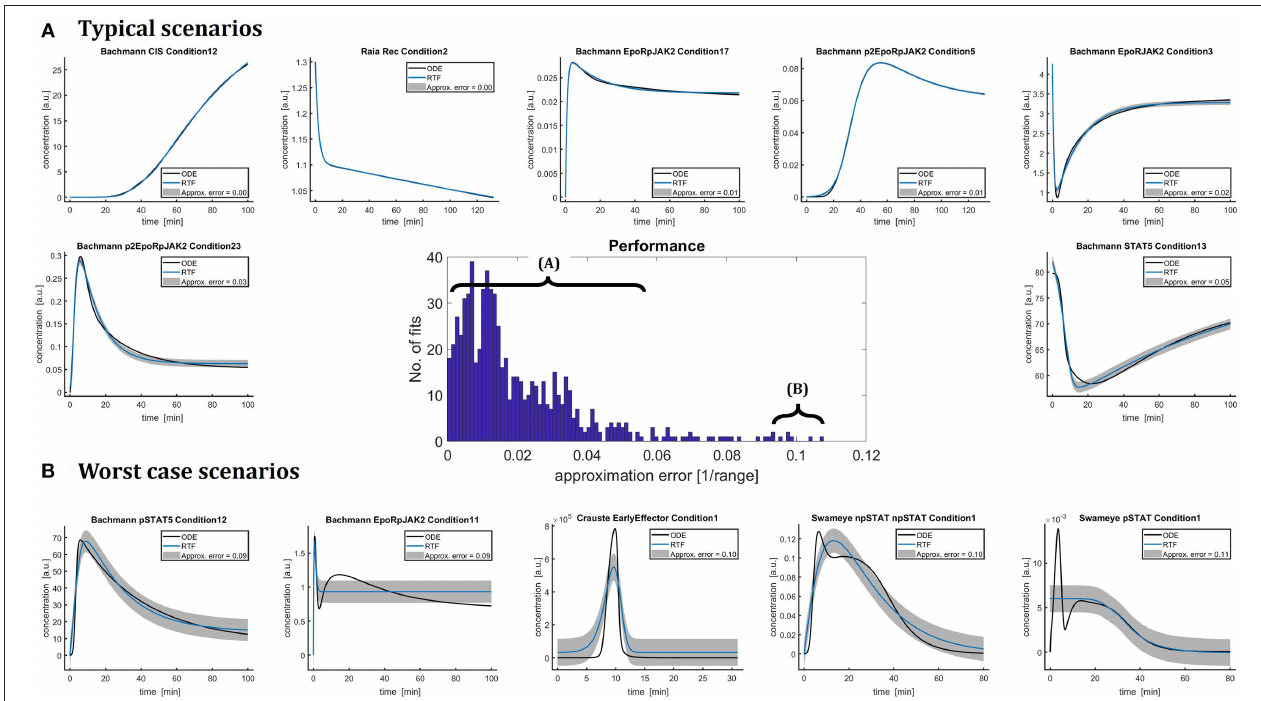
FIGURE 2 | The dynamics of 797 numerical ODE solutions x ( t ) from the nine different benchmark models were fitted by the RTF in order to assess and illustrate the capacity of the RTF (11), (12) for approximating ODE solutions (black lines). The underlying equations of the ODE models originate from the original publications and were taken from the benchmark collection [ 2]. The fitting has been performed based on (13), (18)–(21). The histogram in the center shows the distribution of the resulting approximation errors (15). These errors are also plotted as gray bands and their magnitudes are indicated in the figure legends. In more than half of all fits, the difference between both approaches is hardly visible. For the other cases, the RTF most of the time describes the dynamics qualitatively. (A) Shows typical scenarios for approximating ODE solutions by the RTF. Limitations of the approach are pointed out in (B) . Here, five representative fits with large approximation errors are